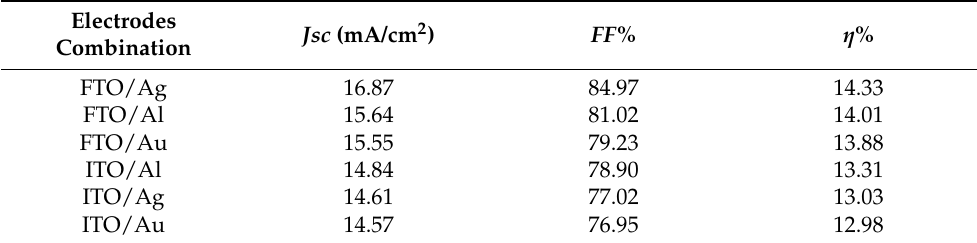
Figure 6. Different investigated electrode configuration: ( a ) FTO/Ag, ( b ) FTO/Al, ( c ) FTO/Au, ( d ) ITO/Ag, ( e ) ITO/Al, and ( f ) ITO/Au. Table 1. Extracted performance parameters with different electrode